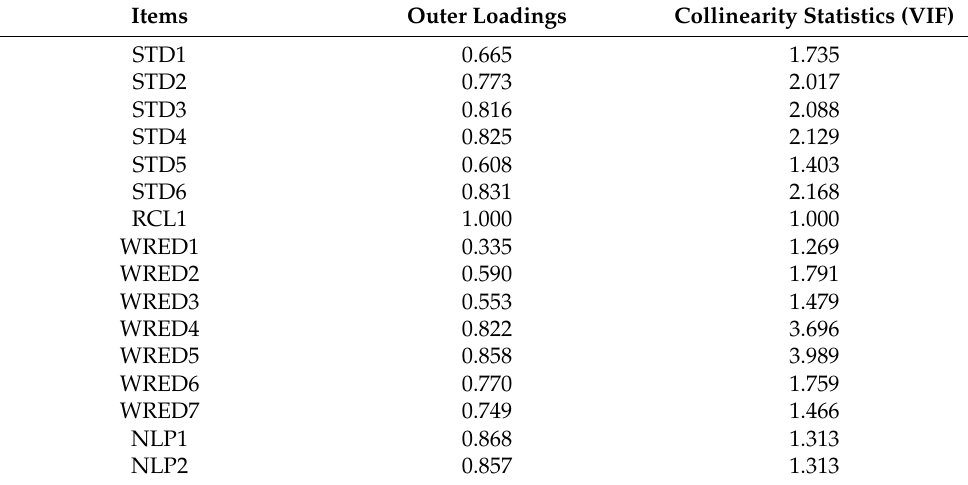
Table 2. Outer loadings and VIF values.